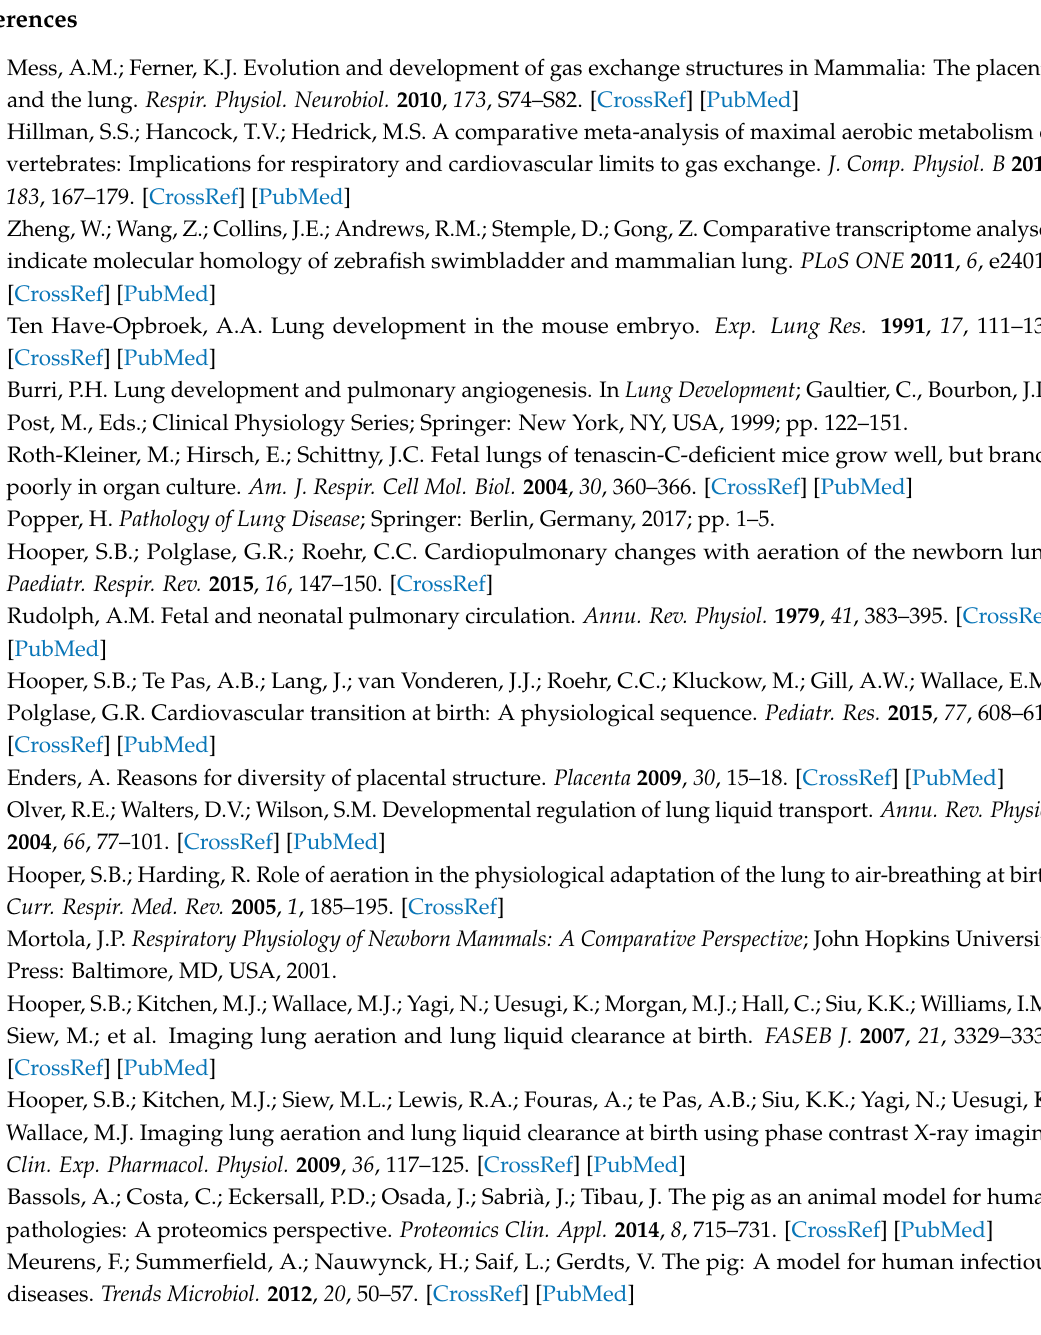
Table S5: Functional enrichment analysis of DE genes in high correlation and nearby loci. Table S6: lncRNA classifications. Table S7: Loci informations of the lncRNA-mRNA